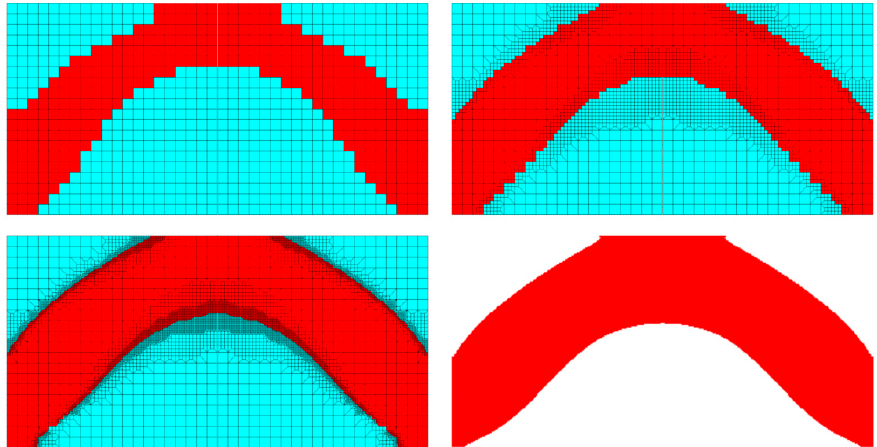
Figure 38. Selected middle topologies and the final one for the structure under self-weight. For the last iteration the grid has not been shown to improve the clarity of the picture.